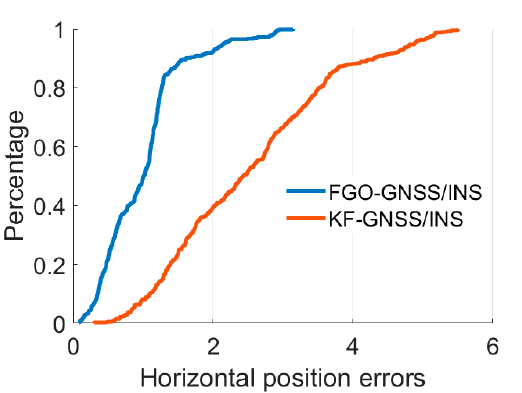
Figure 6. Cumulative distribution function (CDF) for the horizontal position errors.